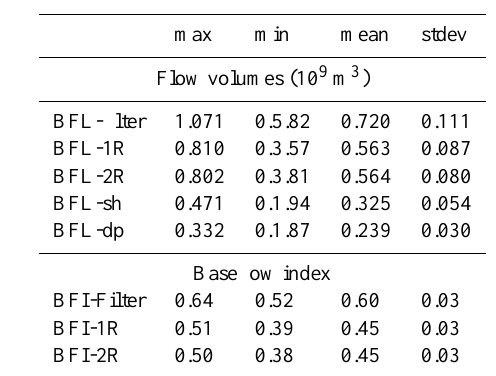
Table 4. Statistical analysis for the baseflow components and base- flow index for Manas River basin, Tianshan, northwest